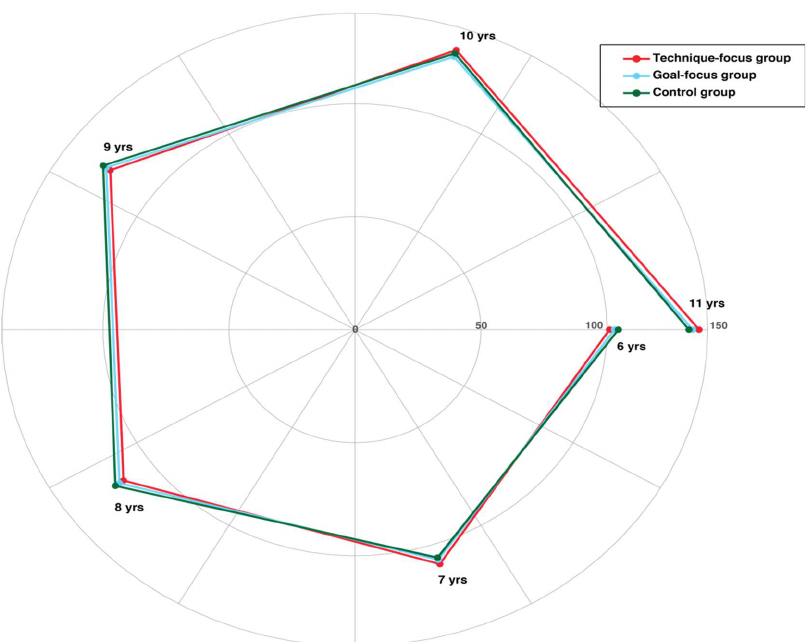
Figure 2. Polar diagram showing the mean scores obtained by all subjects for the SLJ task during the practice phase. Unlike the results from Experiment 1 using the PBT task, for Experiment 2, there was no significant difference in the SLJ performances ( p = 0.24) among the technique-focus (red line), goal-focus (cyan line) and control (green line) groups.